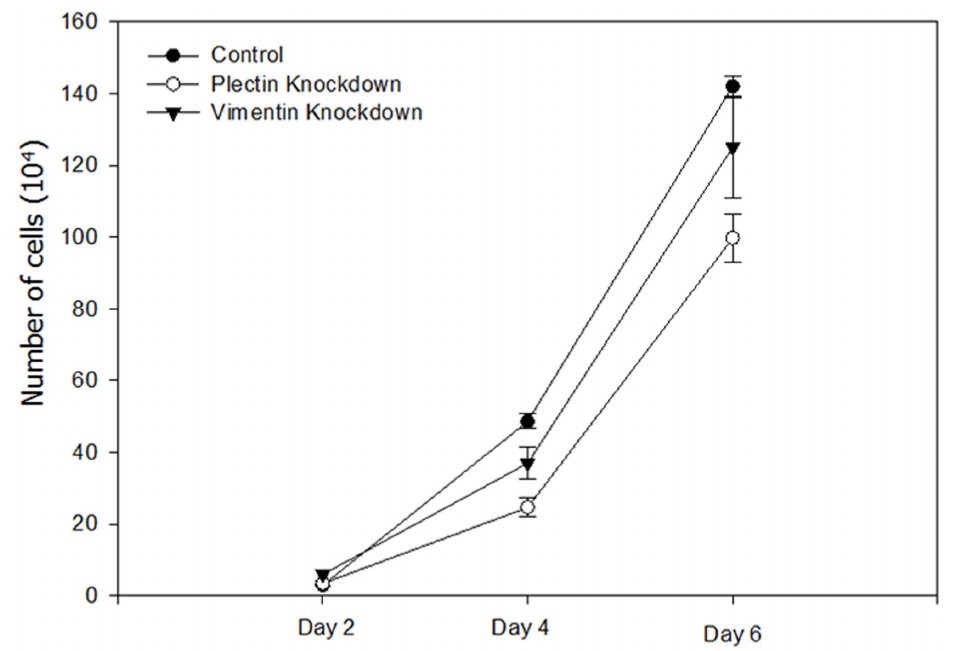
Figure 5. Suppression of plectin and vimentin inhibits the proliferation of PC3-ML2 cells. Cells were transfected with control, plectin and vimentin siRNA. Cells were cultured and counted every two days for at total of 6 days. There is a significant difference in the proliferation rates between control siRNA compared with plectin and vimentin siRNA, P , 0.05.